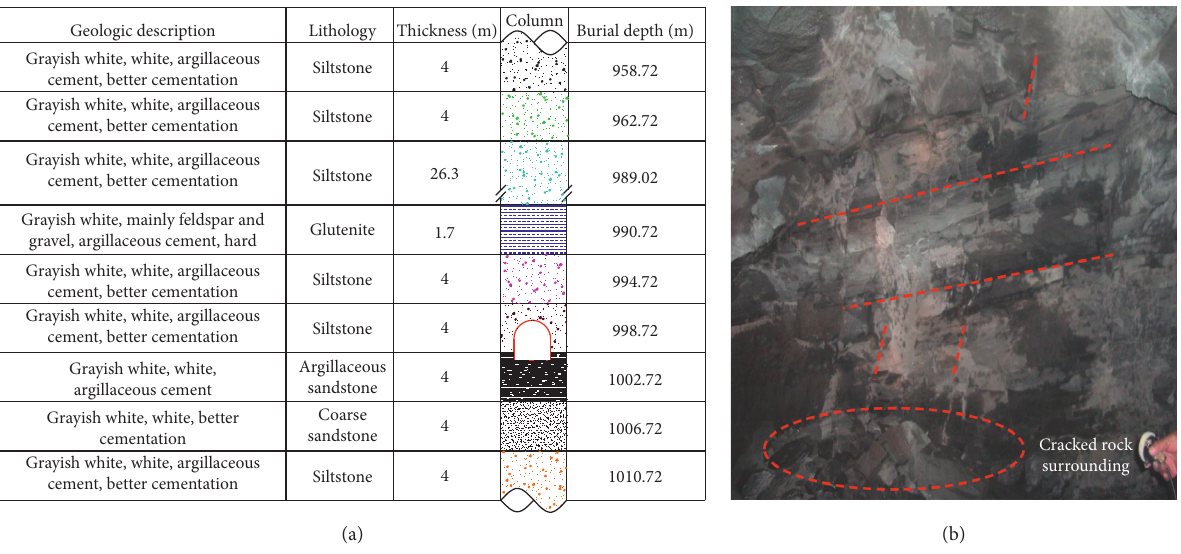
Figure 2: (a) Strata histogram and geologic description. (b) Surrounding rock